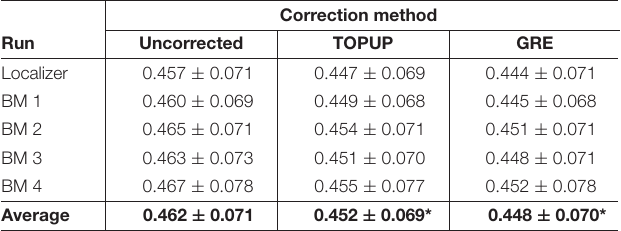
TABLE 4 | Average cost function values (across subjects) of the boundary-based registration of the middle volume of each run (localizer and four biological motion runs) into the structural image, for the uncorrected, TOPUP corrected and GRE-corrected fMRI